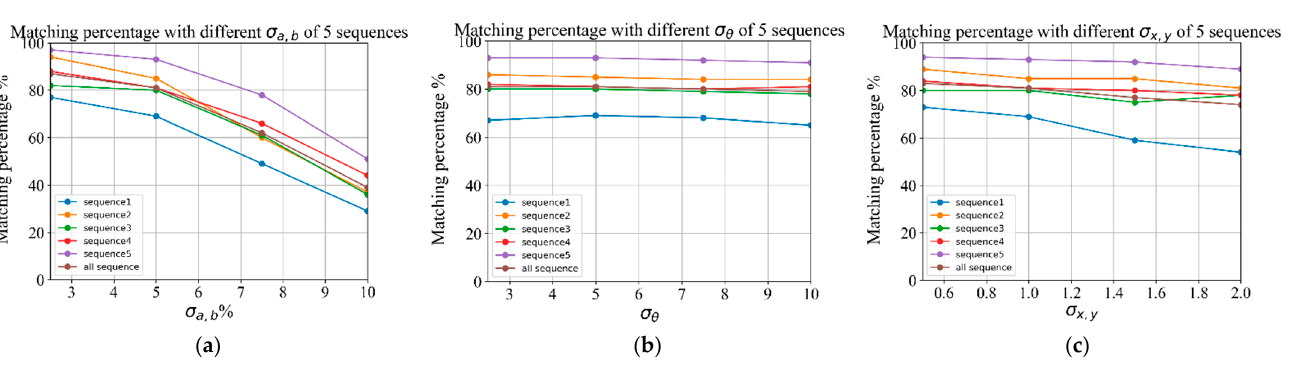
Figure 17. Matching percentage with different noise for five sequences.